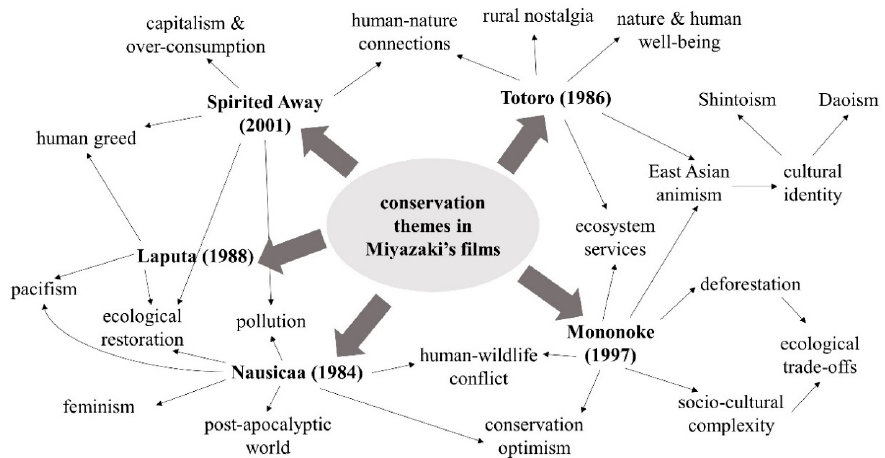
Figure 1. A summary diagram of conservation-orientated and other themes found in Hayao Miyazaki’s animated films.